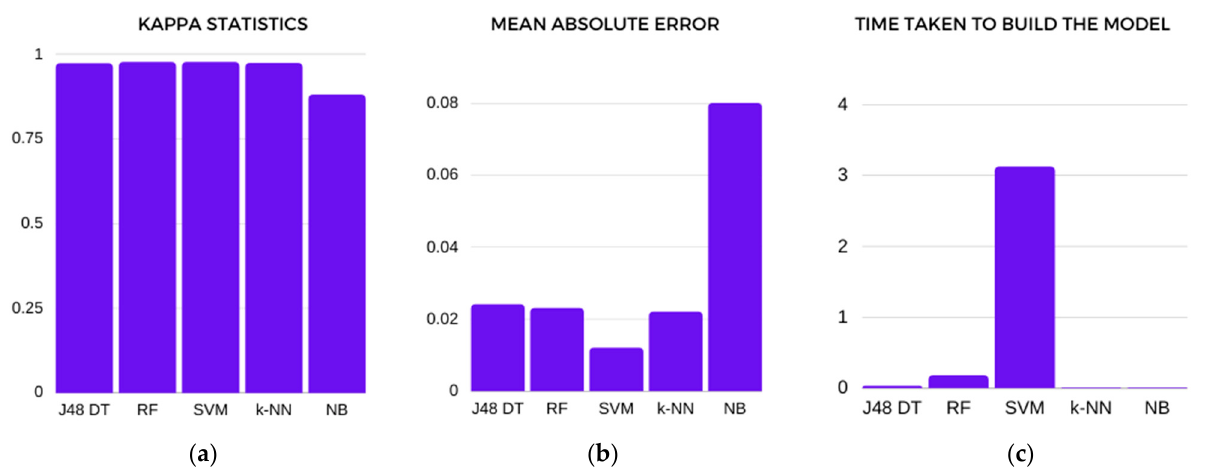
Figure 10. The barcharts for the kappa statistics ( a ), mean absolute error ( b ) and time taken to build the model ( c ).